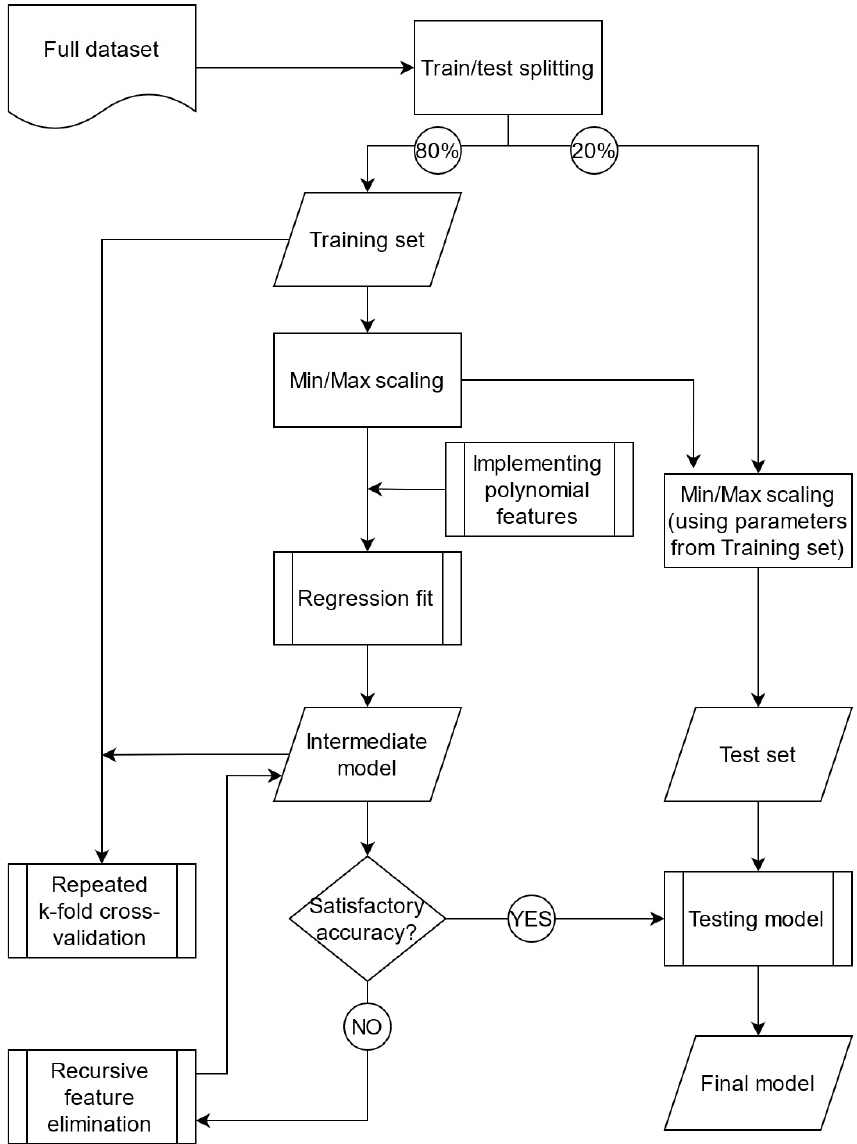
Figure 5. ML-based algorithm for the multiple polynomial regression applied on the complete experimental dataset.